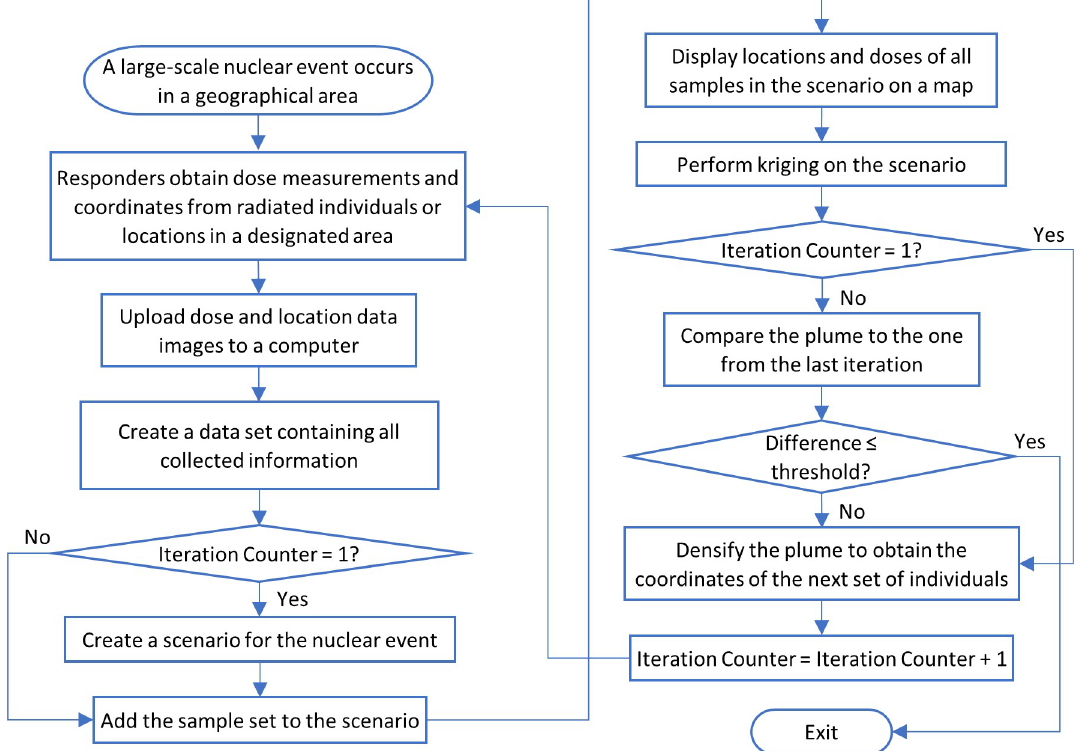
Fig 1. The workflow for handling a population-scale radiation event. First responders collect dose measurements and coordinates of the tested individuals or locations. Measurements are then collected and mapped. A dose plume is generated, and densification is used to select locations with lower confidence radiation estimates for follow-on sampling. These steps are repeated until output plume dosimetry levels converge. The resultant plume can be used to differentiate locations associated with significant exposures ( � 2Gy) from those below this or other